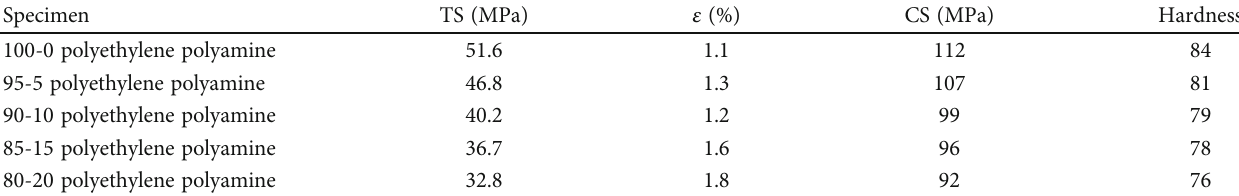
Table 5: Mechanical properties of polyethylene